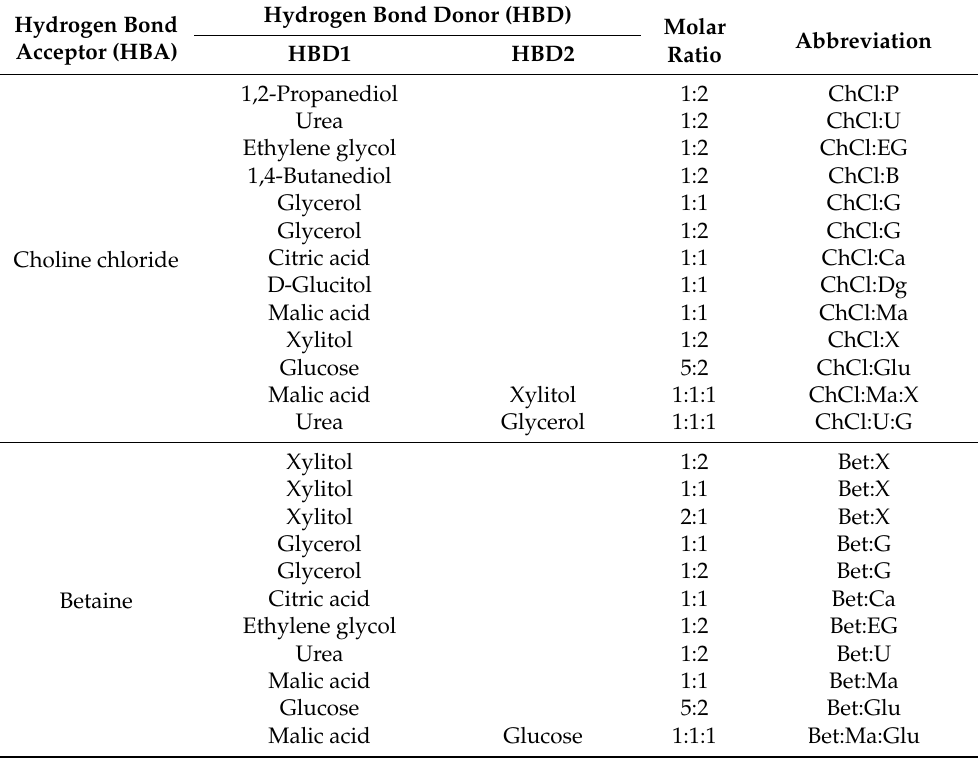
Table 1. The molar ratio of the hydrogen bond acceptors (HBA) and hydrogen bond donors (HBD) for DES